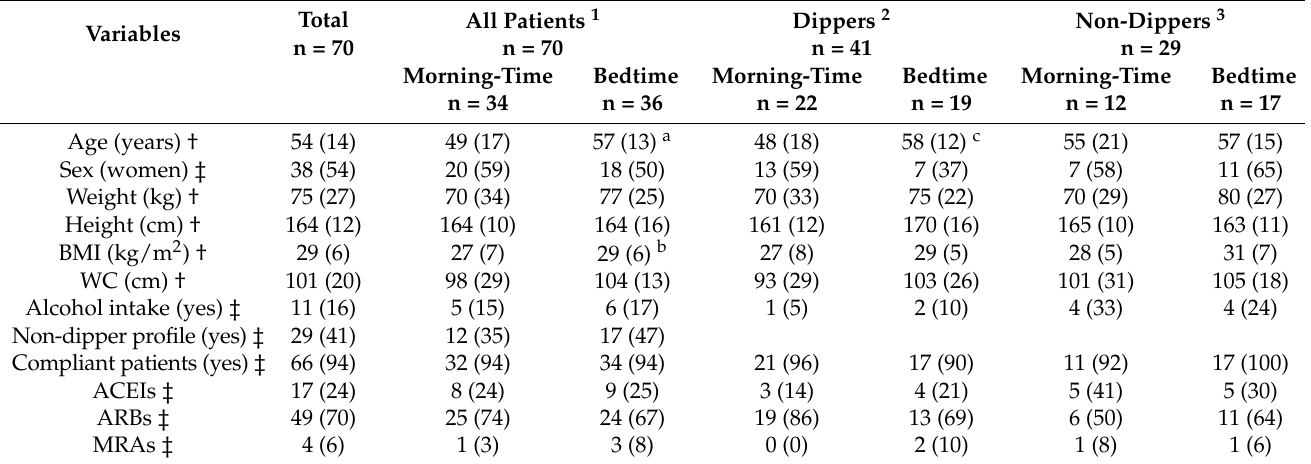
Table 1. Clinical variables. Comparisons between morning and bedtime use of RAAS blockers in dipper and non-dipper hypertensive